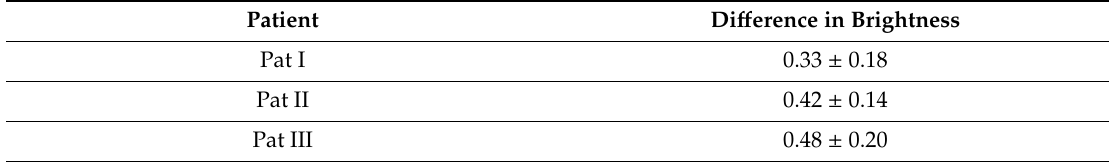
Table 4. Average di ff erence in brightness value included standard deviation ( ± SD).